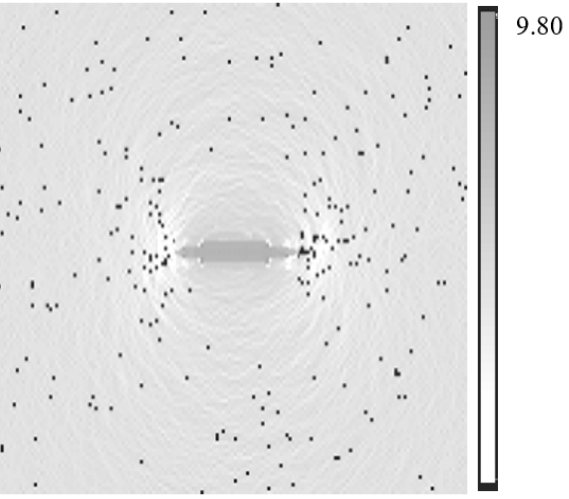
Figure 10. Variation of the equivalent thermal expansion coefficient with water transport flux.